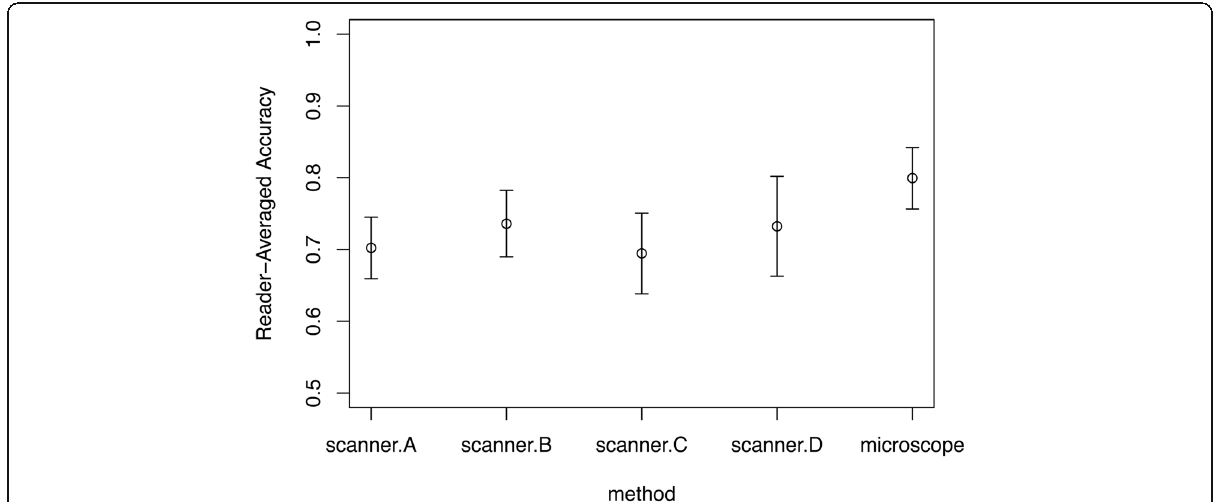
Fig. 3 Accuracy (average of sensitivity and specificity) for each viewing mode averaged over all the readers with 95% confidence intervals. The asterisks indicate that the difference in accuracy of the viewing mode compared to that of microscopy is statistically significant. All analyses account for the correlations and variability from the readers reading the same